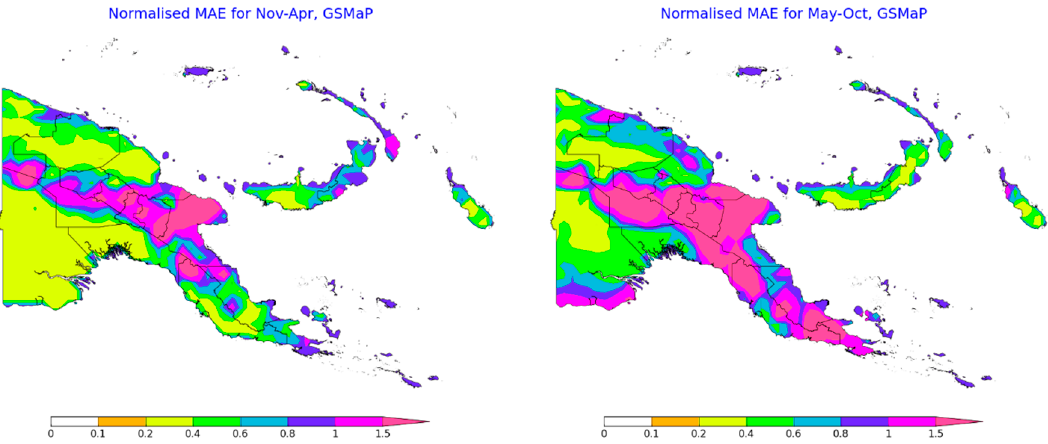
Figure 7. Seasonal gridded areal comparison from January 2001 to December 2018 using ERA5 as truth. Normalised mean average error (MAE) is displayed.